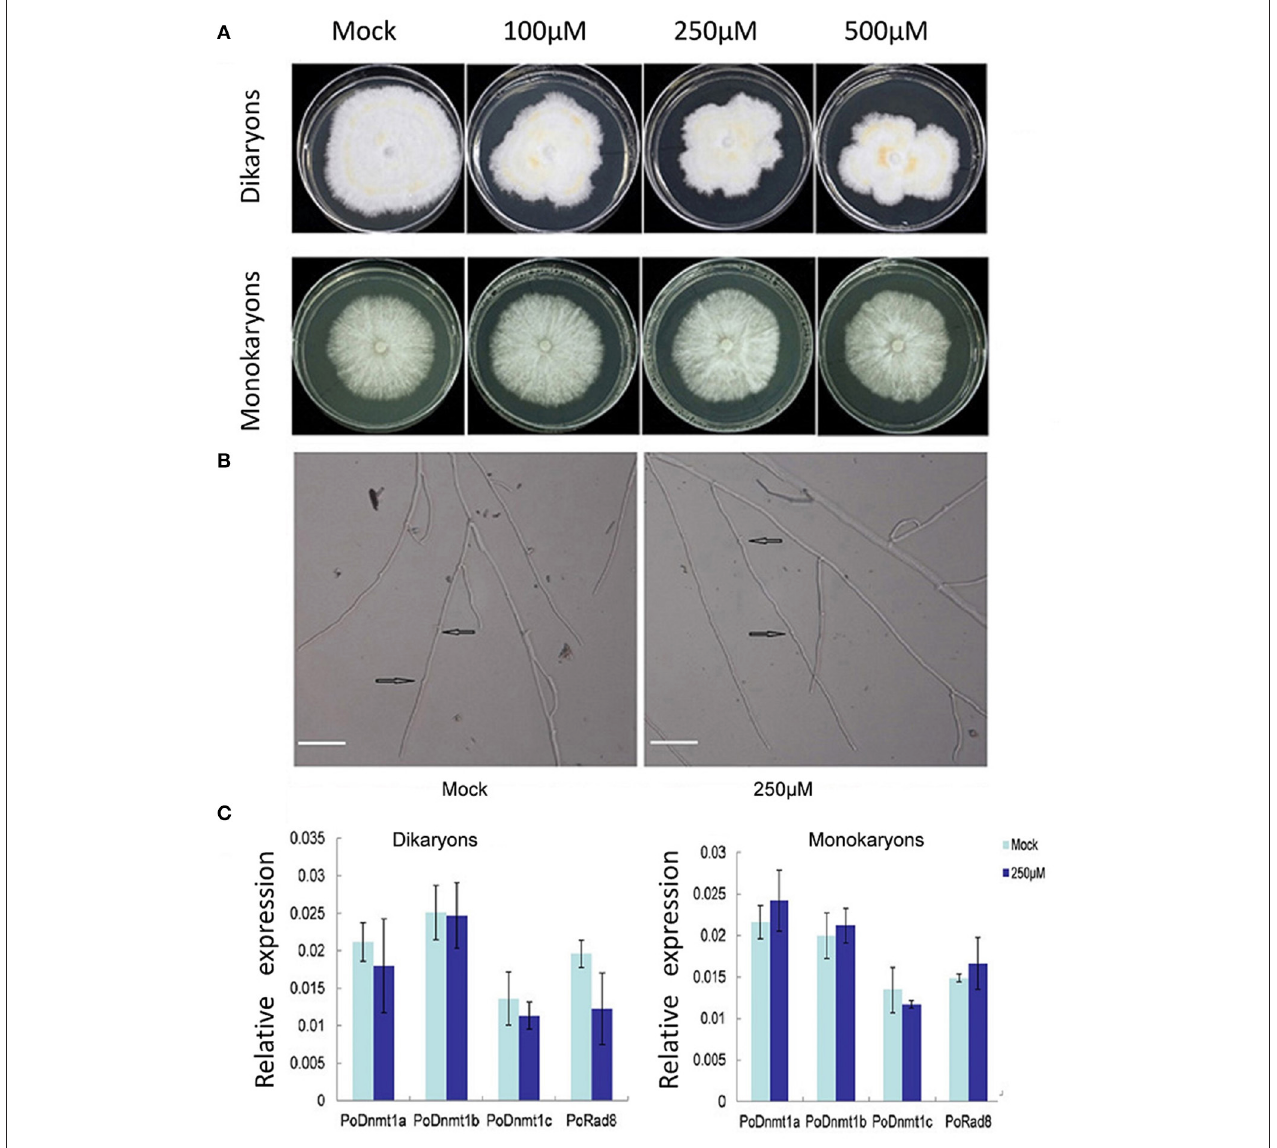
FIGURE 5 | Dikaryons are more sensitive to the inhibitory effect of 5-azcytidine than monokaryons. (A) Dikaryons and monokaryons grown on 5-azacytidine -containing medium with 100, 250, or 500 µ M 5-azacytidine. Images of dikaryons and monokaryons were taken 10, 14 days after inoculation, respectively. (B) The cell length of 5-azacytidine treated dikaryons is longer than that of the mock. The arrow indicates where the clamp connection forms. (C) Expression profiles of putative DNMtase genes in dikaryons and monokaryons after 5-azacytidine treatment for 10, 14 days. The values shown are means ±